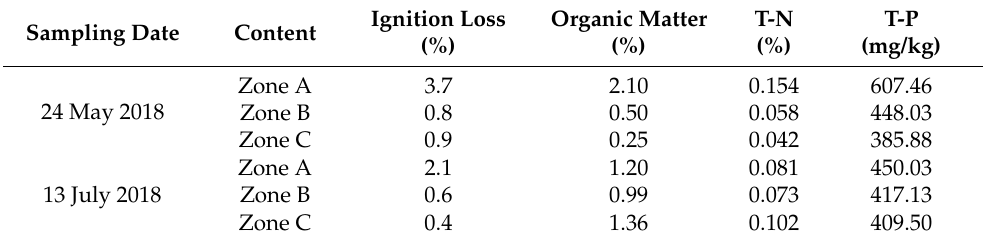
Figure 1. Diagram of the study watershed. Table 2. Bottom soil characteristics of the Ganwol estuarine